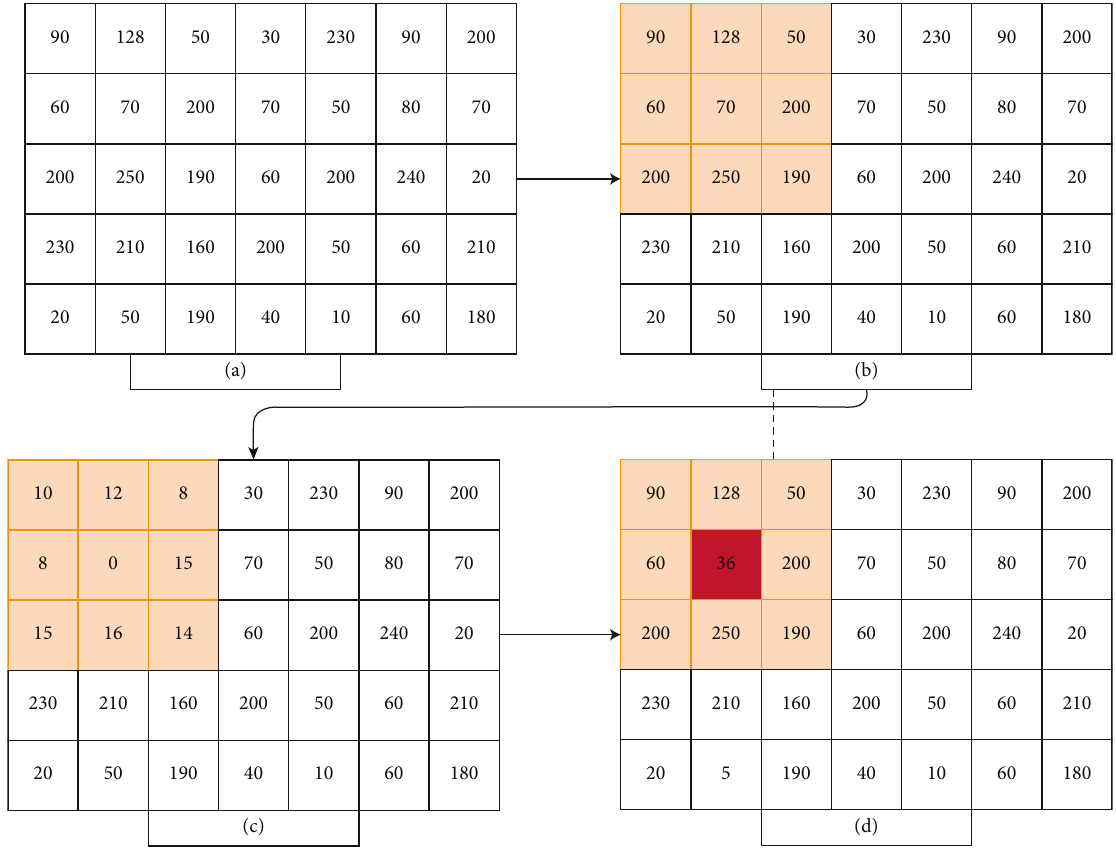
Figure 1: Demonstration of the steps to compute the square root value. The result would be varying based of P value and each value of square root must be rounded off. (a) Example of the original example of the image, (b) The determination of 3 neighbors, (c) The square root of 3 neighbors of center value, and (d) The final equation result value with P �